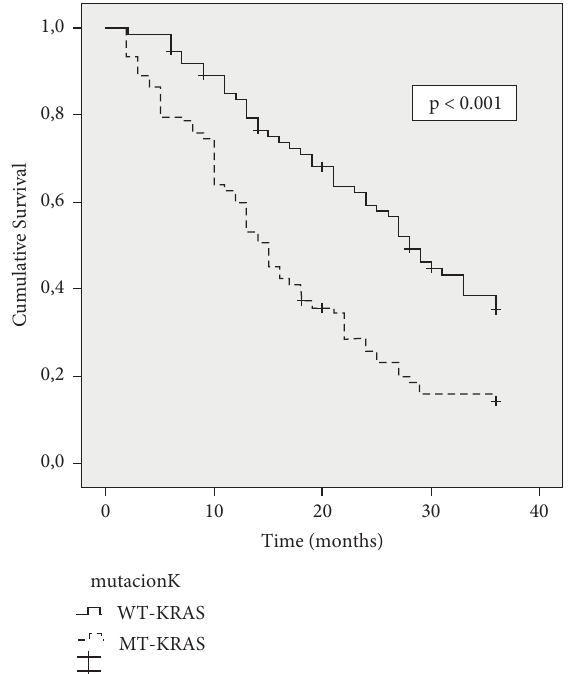
Figure 1: Kaplan–Meier survival function curve in the entire cohort according to KRAS mutation status. The horizontal bar denotes median survival.